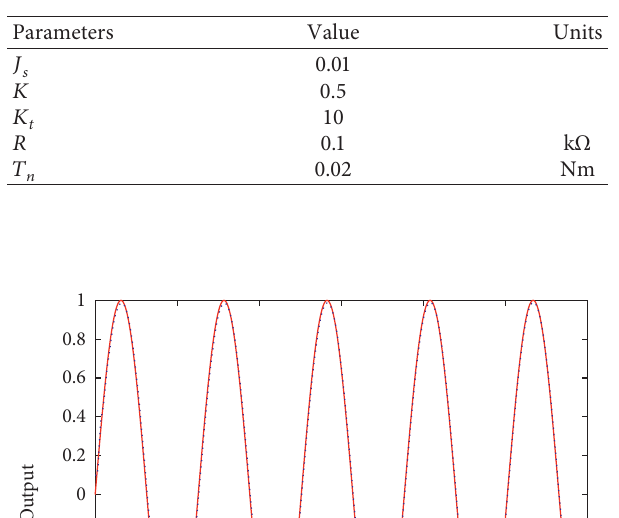
Figure 5: The trajectory of the controller input.